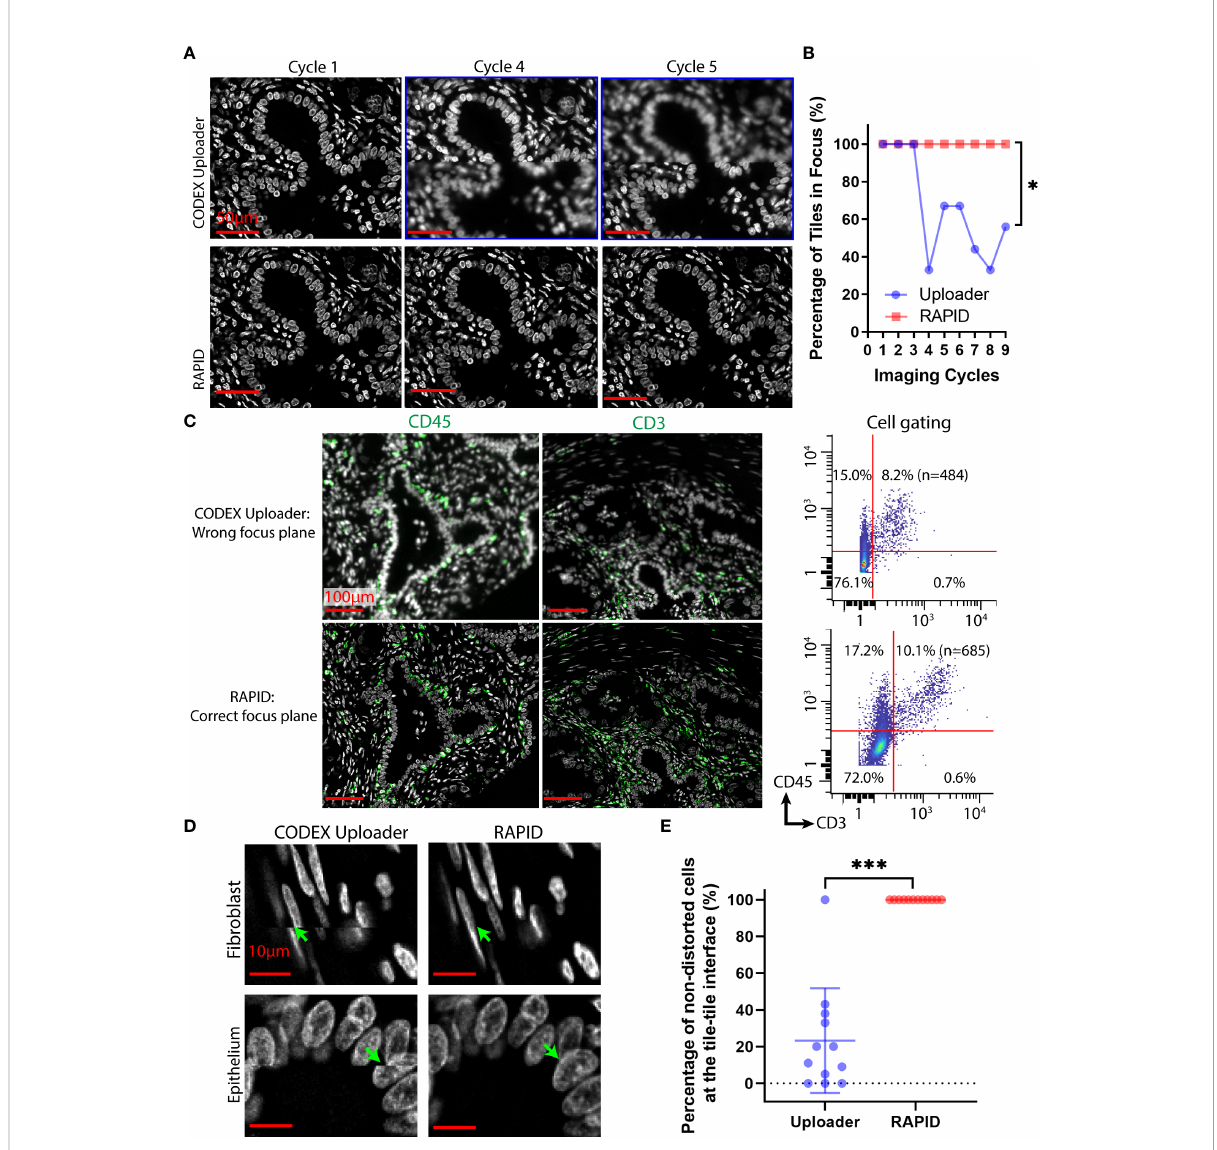
FIGURE 3 RAPID corrects axial and lateral drifts in CODEX multiplexed data. (A) Representative CODEX nuclear images from cycles 1, 4, and 5 of a PDAC tissue section processed by the CODEX Uploader and by RAPID. (B) Percentage of in-focus tiles across nine tiles and nine imaging cycles for one example tissue region. (C) Representative CODEX images of PDAC tissue section stained for CD45 and CD3 processed by the two pipelines, and the corresponding cell gating using CD3 and CD45 protein expression. (D) Representative images of fi broblasts and epithelium processed by the two pipelines. (E) Percentage of the non-distorted cells across the twelve tile-tile interfaces of an example tissue region. Wilcoxon matched-pairs signed rank test was used in (B, E) . *P < 0.05, ***P <